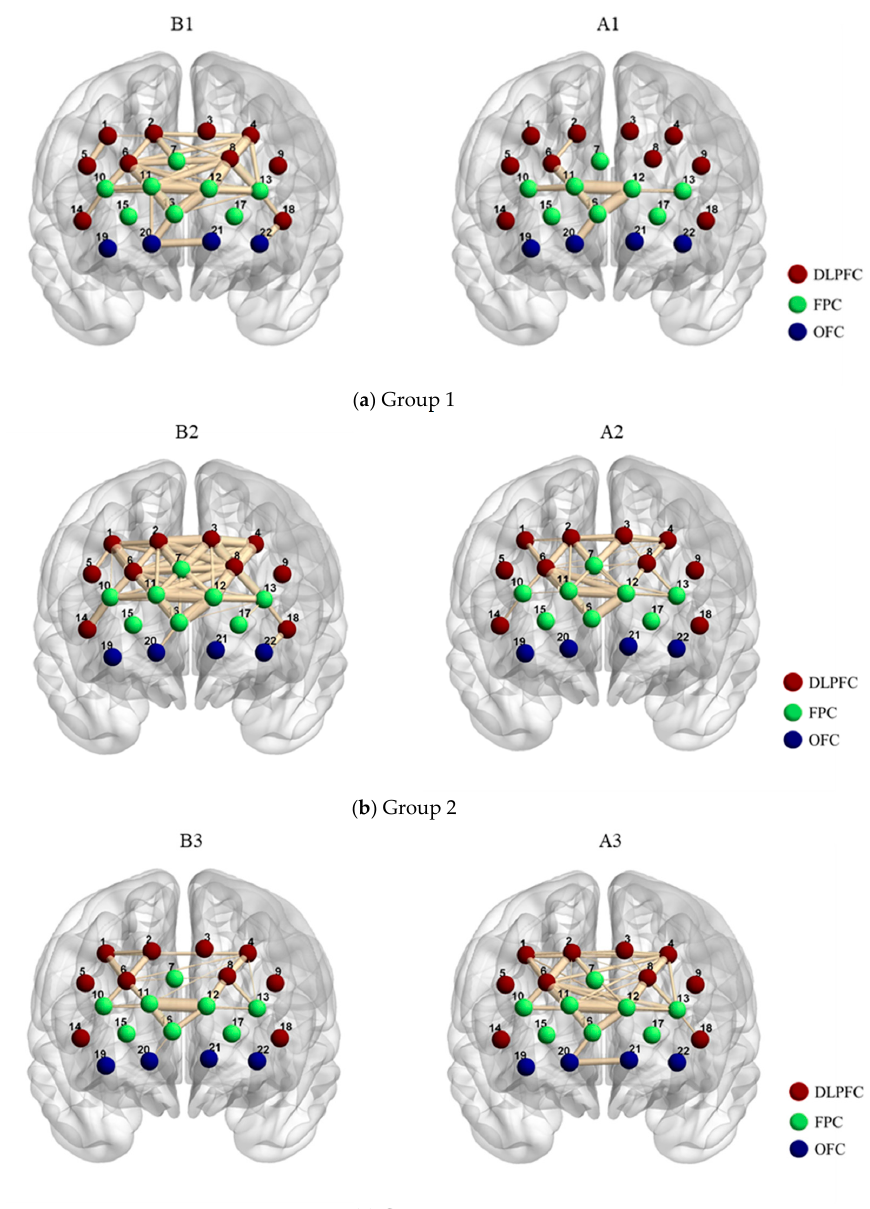
Figure 4. The group connectivity was calculated from oxy_Hb before and after work in 3 shifts of coal mine workers. Only connections with absolute z-values greater than 0.7 were displayed. Brain map images were generated using BrainNet Viewer software [58]. ( a ) Group 1. ( b ) Group 2. ( c ) Group